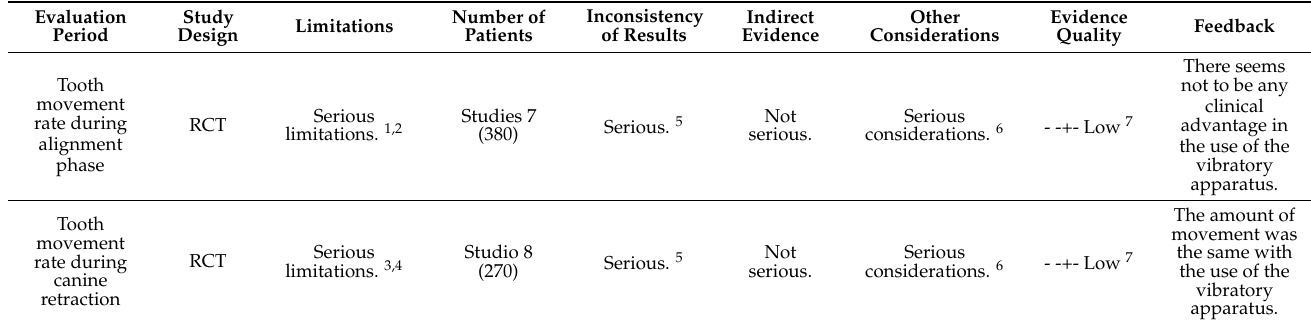
Table 3. Population: Patients with orthodontic treatment. Intervention: Vibratory